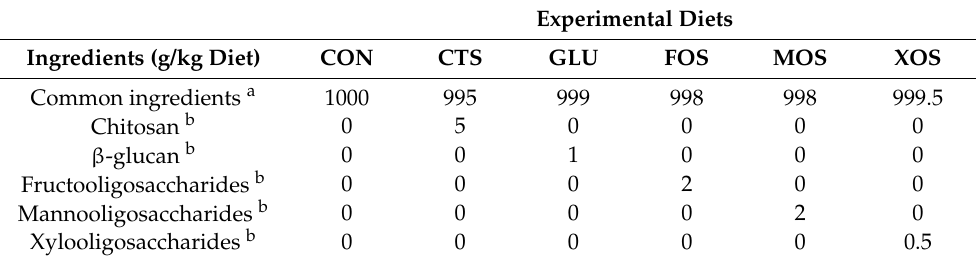
Table 1. Ingredients of the experimental